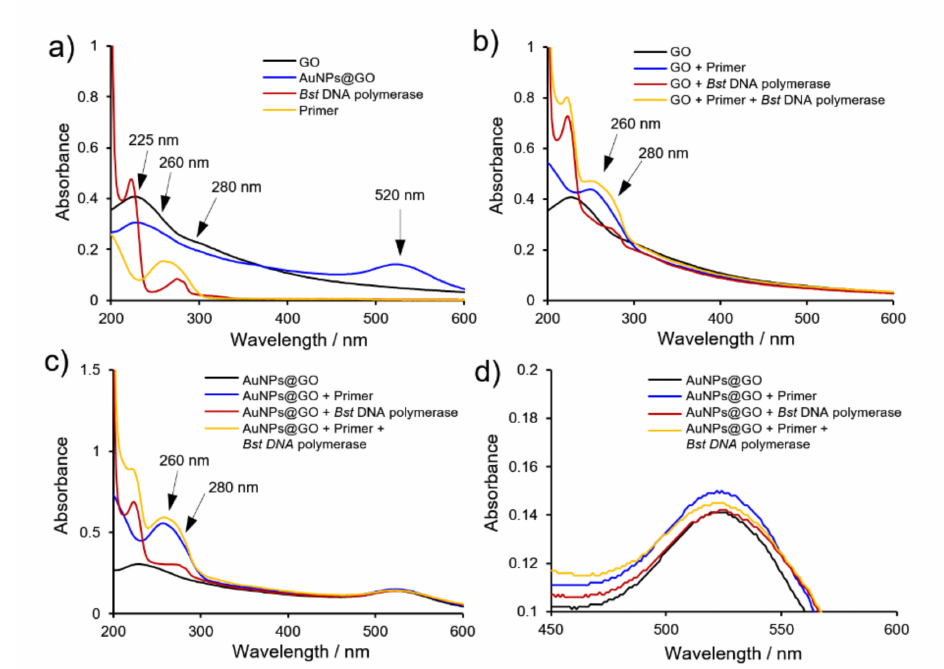
Figure 6. ( a ) UV-vis spectra of graphene oxide (GO), GO–AuNPs (AuNPs@GO) nanocomposite, Bst DNA polymerase, and LAMP primers. ( b , c ) Absorbance changes on addition of primer, Bst DNA polymerase, and both in b) GO and ( c ) AuNPs@GO nanocomposite. ( d ) Enlargement of absorption peak of AuNPs on GO sheets from ( c